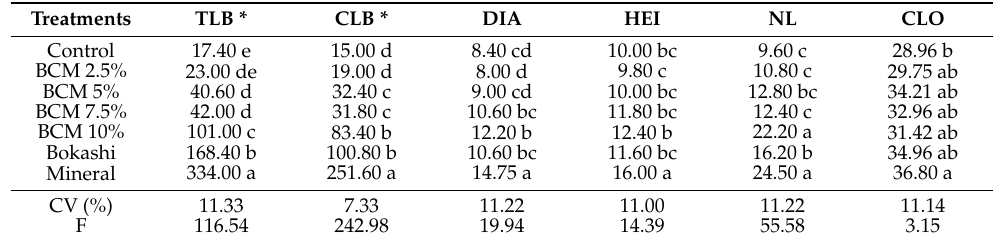
Table 1. Means of production variables of iceberg lettuce submitted to boiled chicken manure (BCM), Bokashi, or mineral fertilizer. Londrina, Brazil, 2020. Treatments